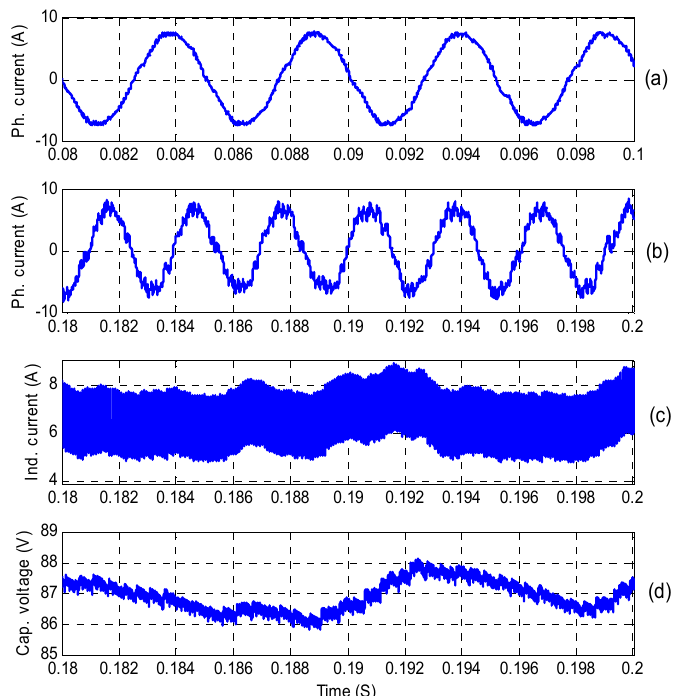
Figure 12. Steady-state performance of the unmodulated MPC at a sampling time of 20µs: ( a ) phase- current below the base speed, ( b ) phase-current above the base speed, ( c ) inductor current in boosting mode, and ( d ) capacitor voltage above the base speed.